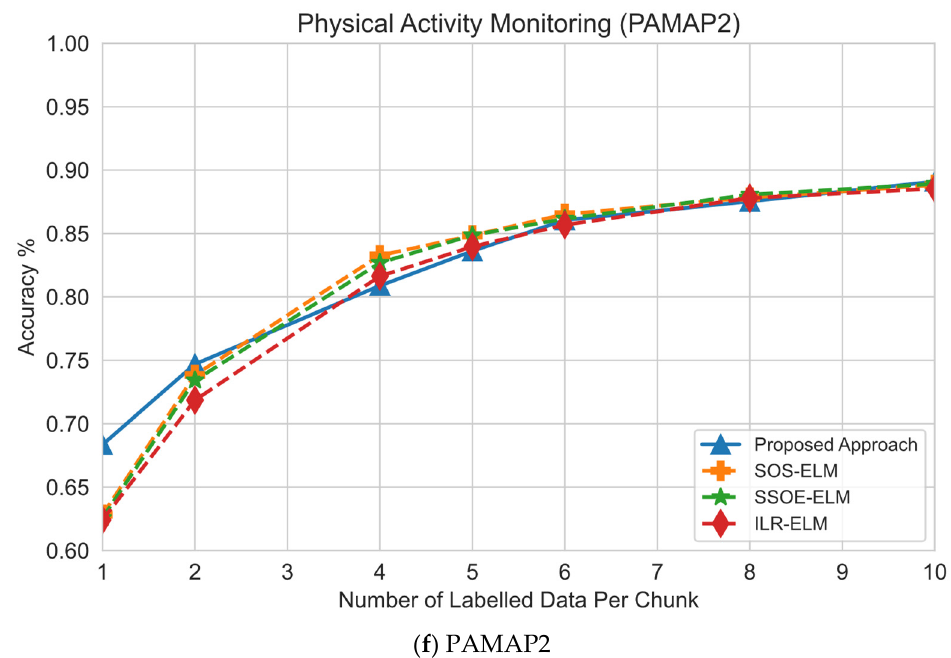
Figure 5. Effect of the size of labeled data on classification performance: ( a ) on sensorless drive data set, this approach performed second best when the fewest number of labeled data was used but no significant improvement to other approaches; ( b ) on magic gamma data set, this approach performed the best regardless of the number of labeled data used; ( c ) on HAR data set, this approach significantly outperformed other baseline approaches on all labeled data sizes but decreased slightly, possibly due to overfitting; ( d ) on the crop mapping data set, this approach performed the best on the fewest labeled data sizes but performed comparably to other approaches as the size of labeled data increased; ( e ) on KDDCup 1999 data set, this approach performed the best when the fewest labeled data were used but the advantage diminished as the size of labeled data increased; ( f ) on PAMAP2 data set, this approach performed the best on the fewest labeled data sizes but performed comparably to other approaches as the size of labeled data increased.